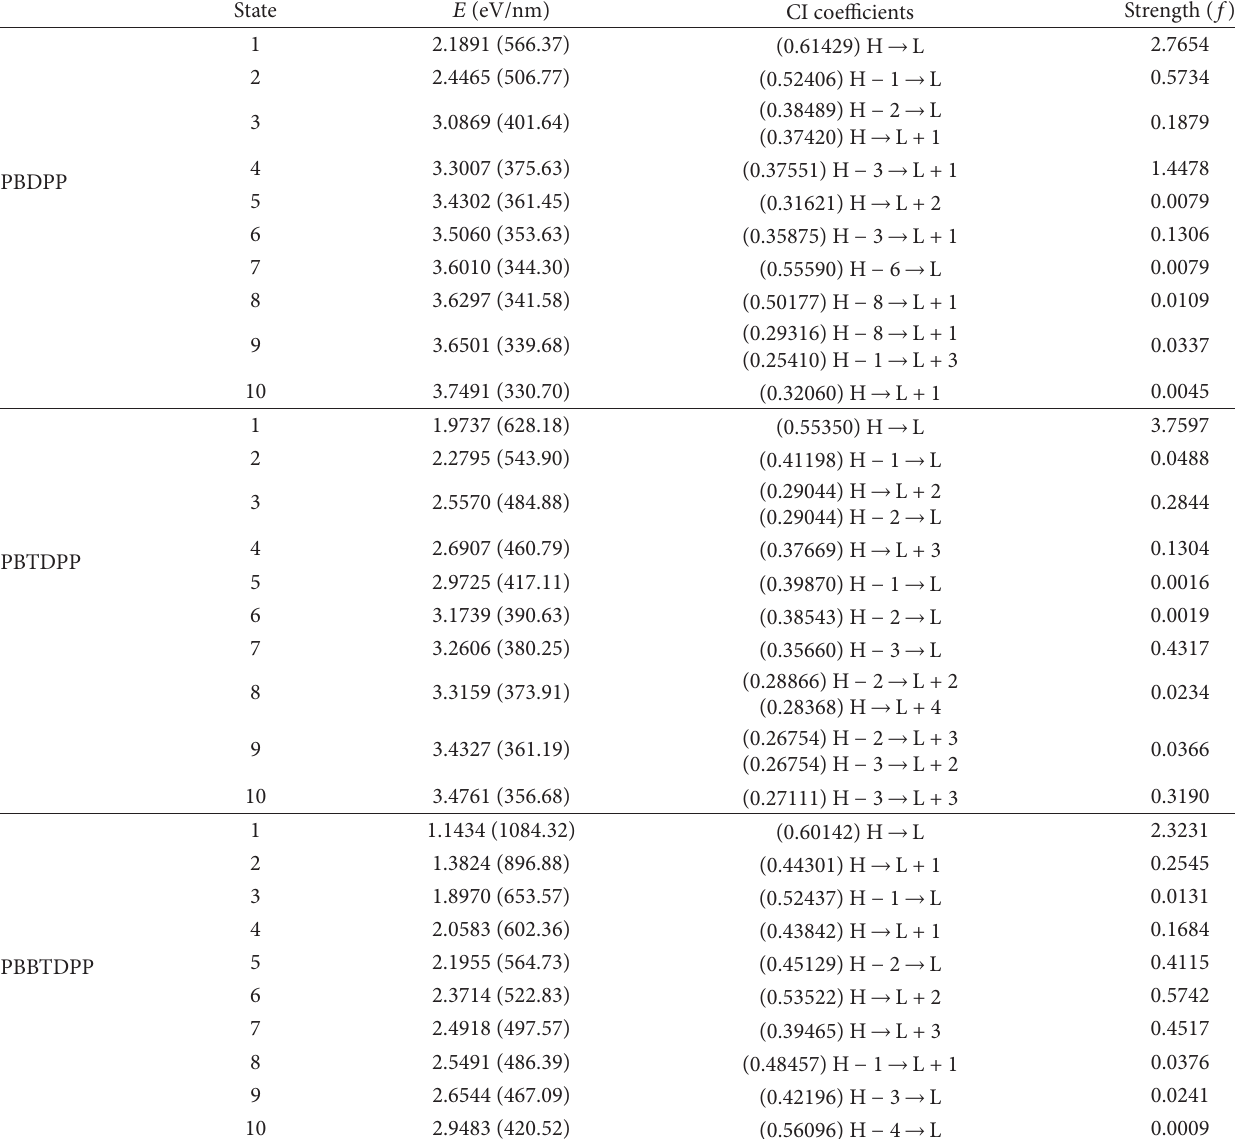
T 2: Calculated transition energies (eV, nm), CI coefficients, and oscillator strengths